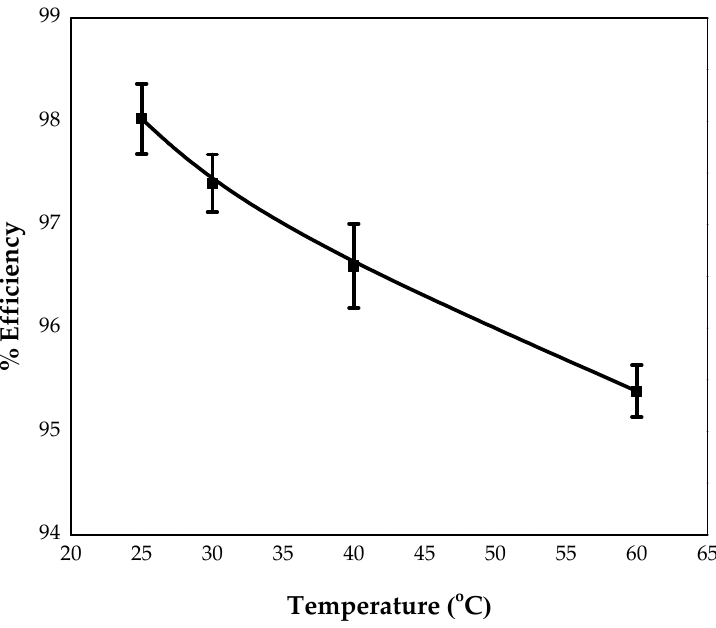
Figure 9. Effect of DES to alizarin volume ratio on the extraction efficiency (initial concentration of alizarin = 1000 mg/L, pH = 6.37, contact time = 5 min, DES dosage = 0.15 mL at 25 °C).